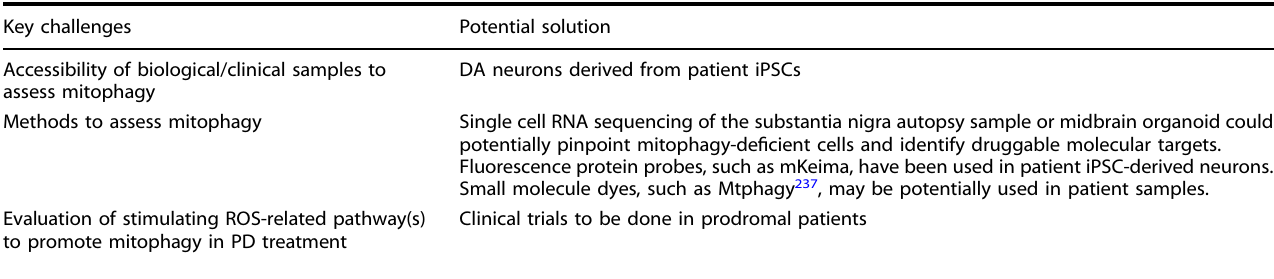
Table 2. Key challenges and potential solution of mitophagy in future clinical